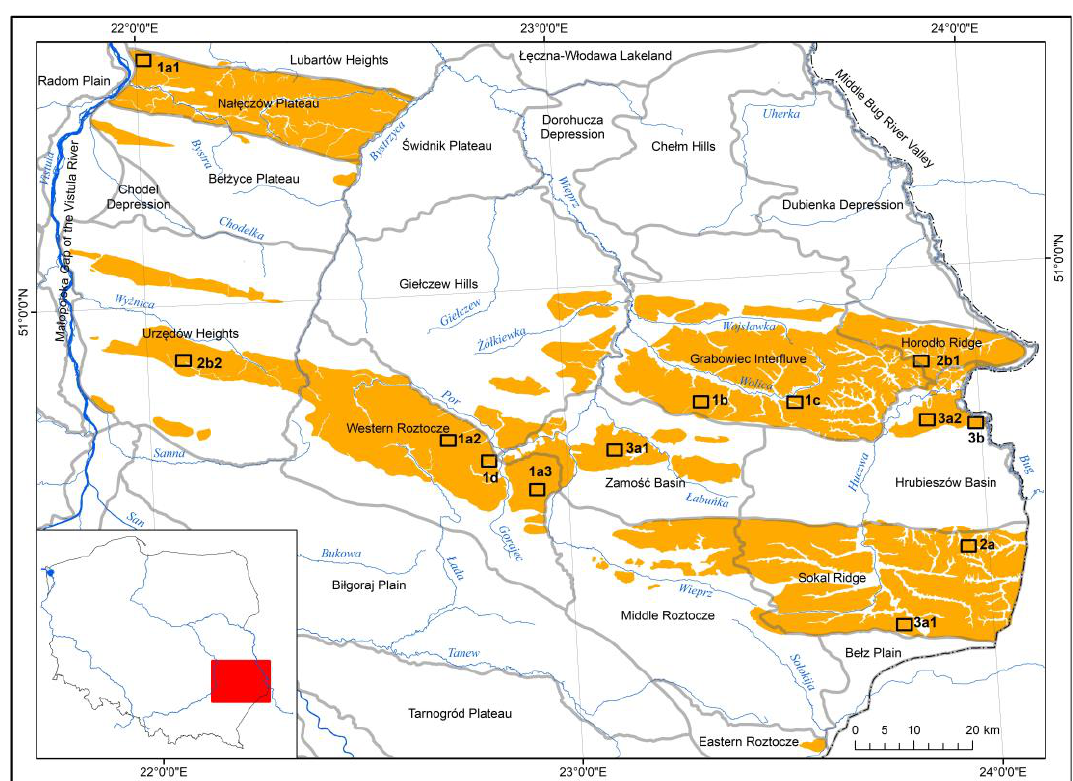
Figure 1. Localization of study area and extent of analyzed loess patches. Boundaries of physical- geographic regions (grey lines) and names, according to Solon et al. [40]. Small frames with numbers show the extent of sample geomorphon maps.